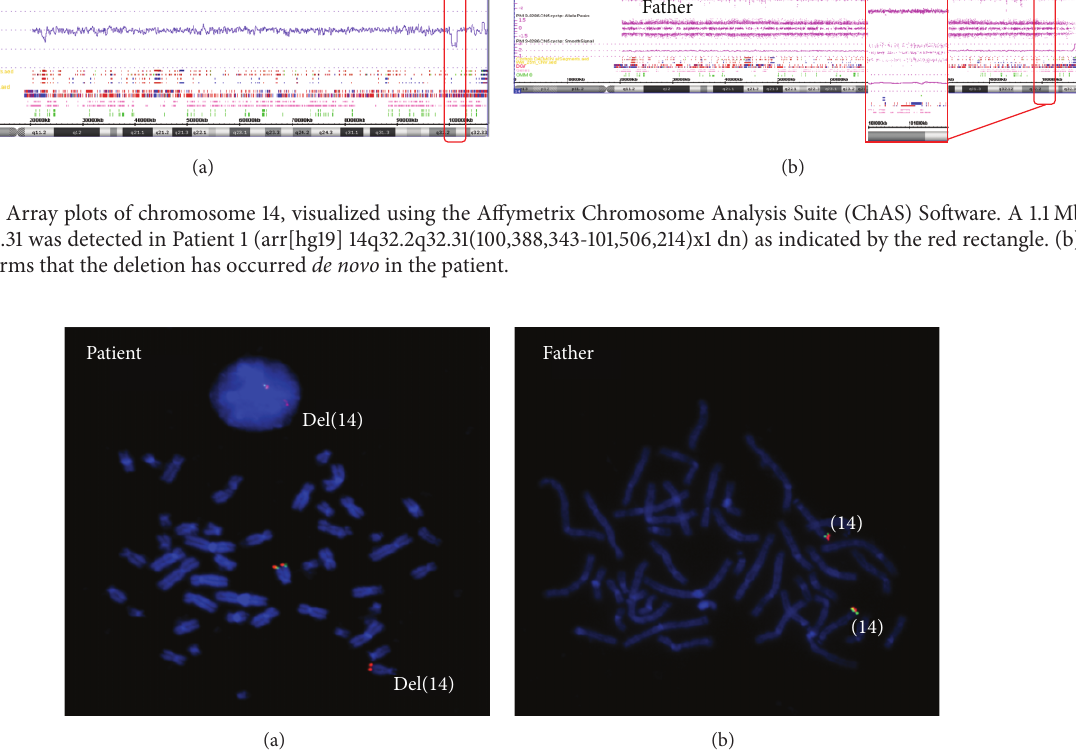
Figure3:FISHstudyinthepatientandherfather.Ineachofthem,30metaphasesfromculturedperipheralbloodlymphocyteswereanalysed. (a) Patient metaphase showing one normal chromosome 14 [RP11-123M6 (green)/14 qter 9(red)] and the del(14)(q32.2q32.31) with only 14qter signal (red). (b) Metaphase from the father with a normal FISH pattern, indicating two normal chromosomes